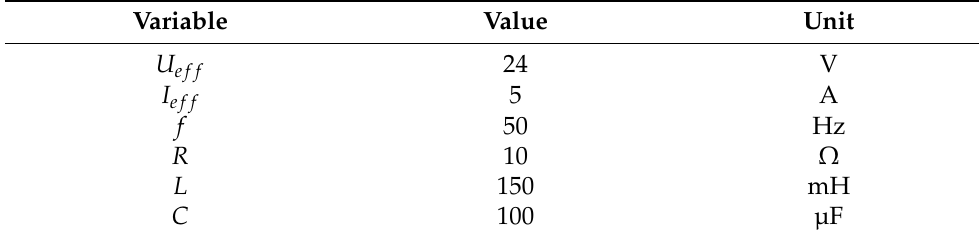
Table 1. Input values for the RLC series and parallel circuit tests.